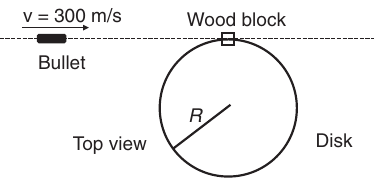
FIG. 1. Two types of synthesis problem: (a) sequential and (b)